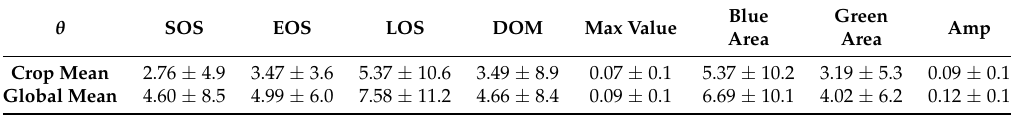
Table 8. Mean absolute deviation (MAD) of phenological metrics derived from the predicted LAI using real GPR models regarding different GPR parametrizations (i.e., using hyperparameter mean disaggregated by crop types and global hyperparameter average). Units: days for SOS, EOS, LOS, DOM; [ m 2 /m 2 ] for max value and amplitude; [ m 2 /m 2 d ] for blue and green